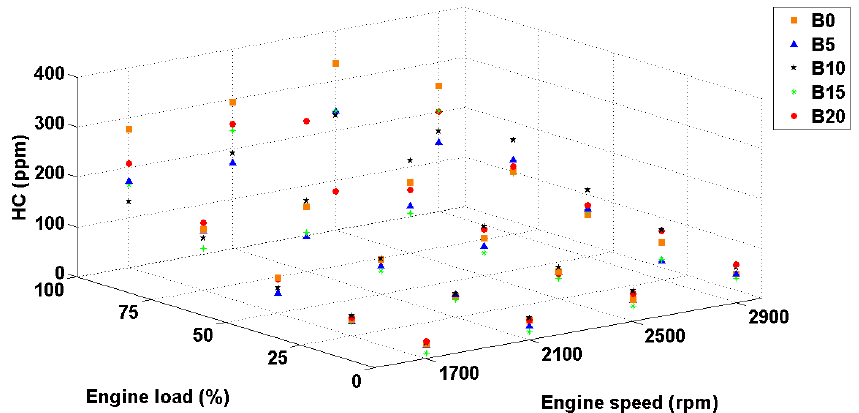
Figure 16. HC emissions of the engine under different engine loads, speeds and biodiesel percentages.